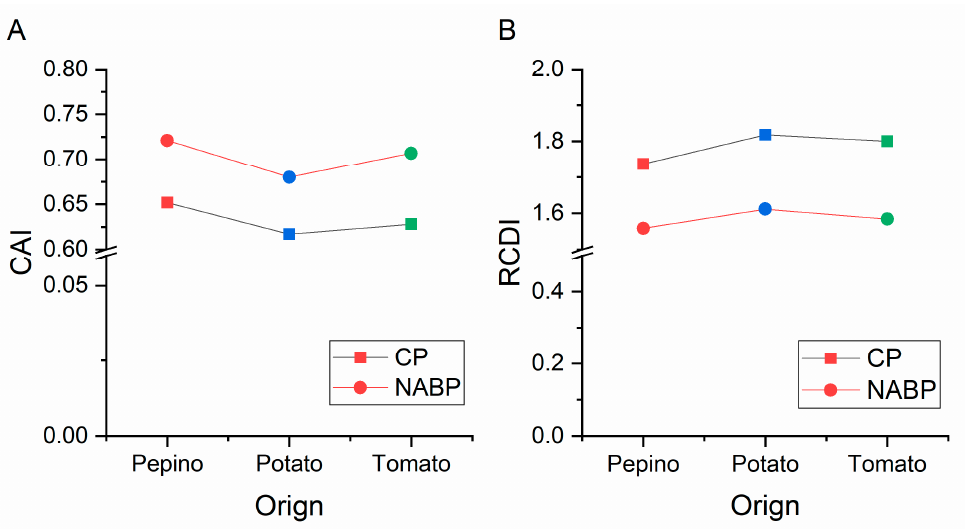
Figure 7. The codon adaptation index (CAI) analysis ( A ) and relative codon deoptimization index RCDI analysis ( B ) of the CP and NABP genes in relation to the natural hosts. The x axis represents the sequences identified in different hosts.